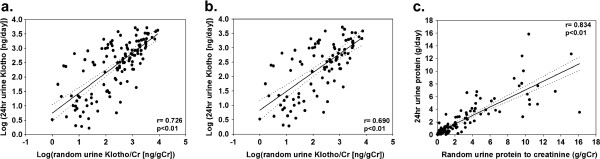
The relationships between the log transformed value of the 24 hr urinary excreted Klotho level and that of the urine Klotho-to-creatinine ratio in all subjects (a) and in the subjects without NS (b), and between the 24 hr urine protein and the random urine protein-to creatinine ratio (c). Note that there was a strong linear dependence between the 24 hr urine protein and the random urine protein- to-creatinine ratio. Solid line: linear regression, dotted lines: 95% confidence intervals.